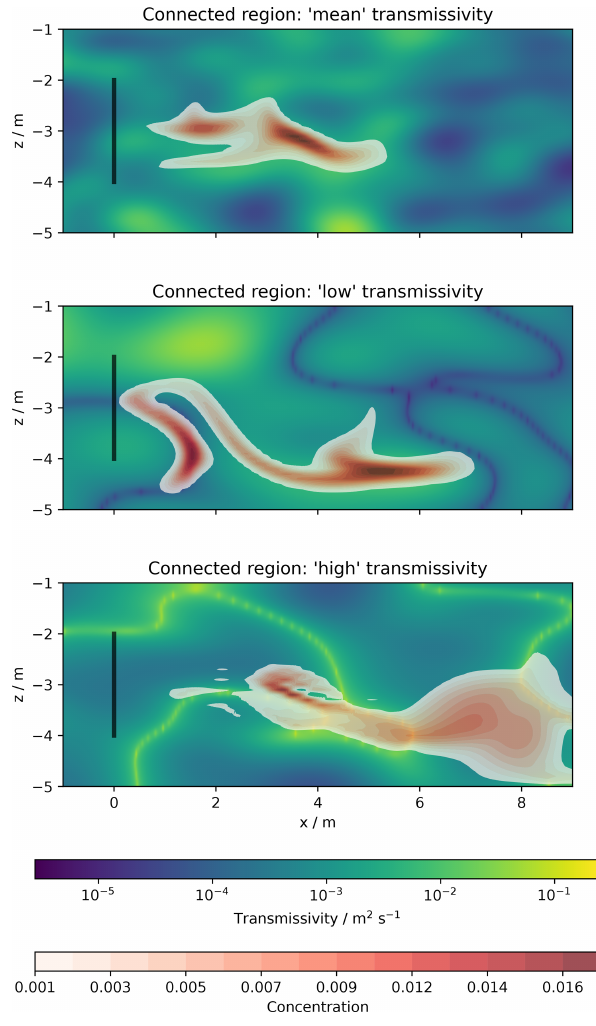
Figure 24. Tracer transport simulation results: spatially distributed concentration plumes after 15d with transmissivity distributions in the